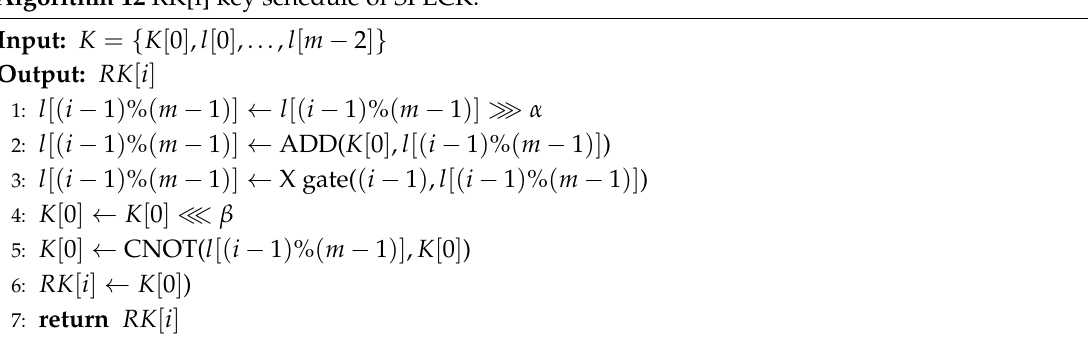
Algorithm 12 RK[i] key schedule of